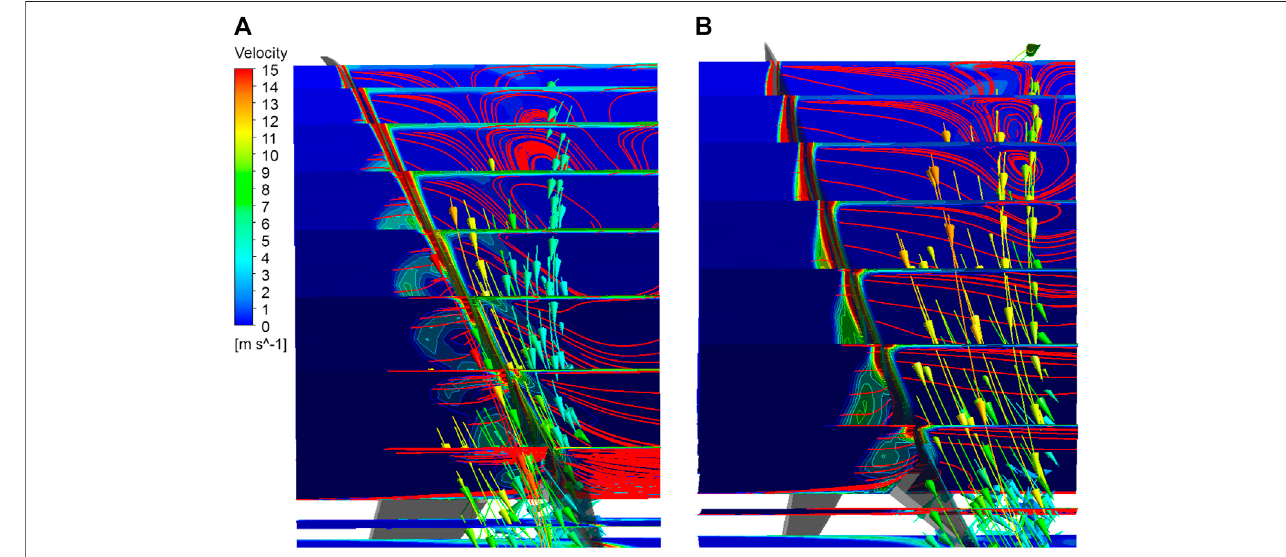
FIGURE 18 | Velocity distribution of the S2 fl ow surface. (A) Original. (B) Optimized.